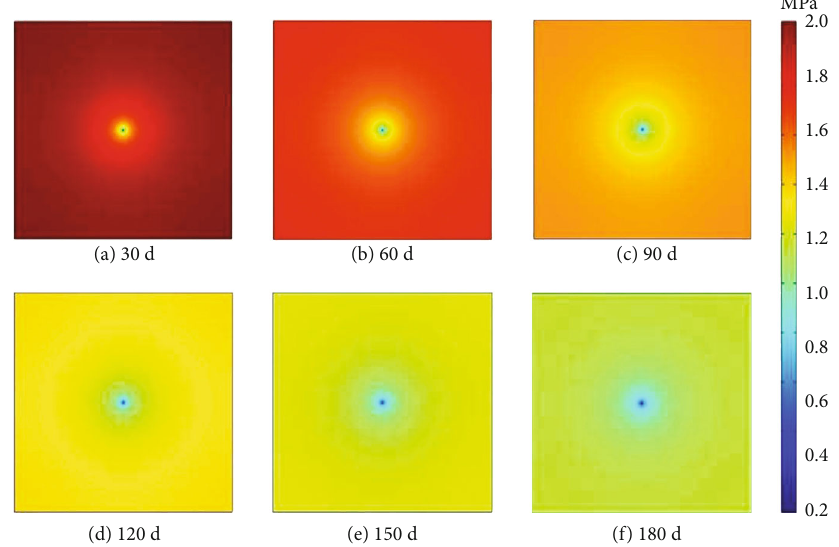
Figure 16: Distributions of gas pressure at varying gas extraction times after unloading disturbance.